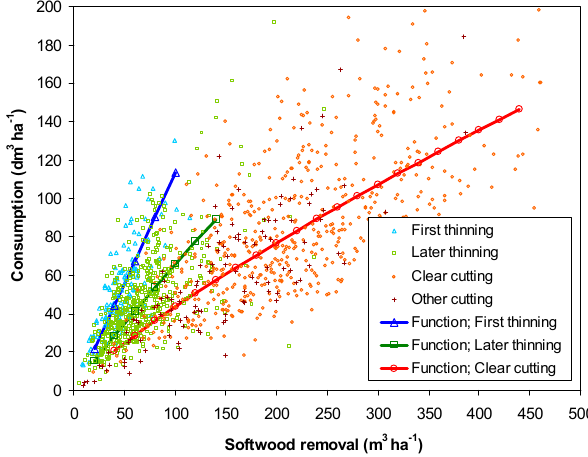
Figure 6. The hectare-based consumption observations of stump treatment material as a function of softwood removal per hectare and the predicted consumption functions by cutting method (cf. Table 4). Table 4. Regression models for the hectare-based consumption of stump treatment material. y 2 = x 2b FT: Adjusted R 2 = 0.628; F Value = 226 ***; Standard Error of the Estimate of the Model = 0.312